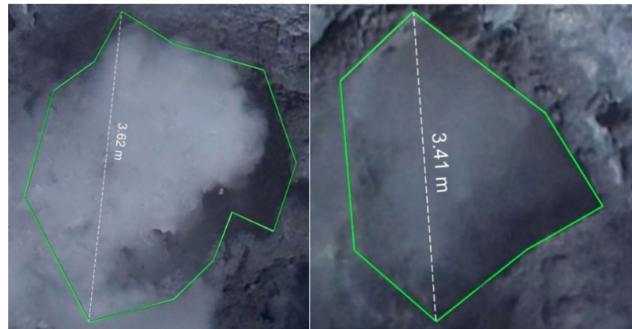
Figure 10. Detail and size of the newly opened